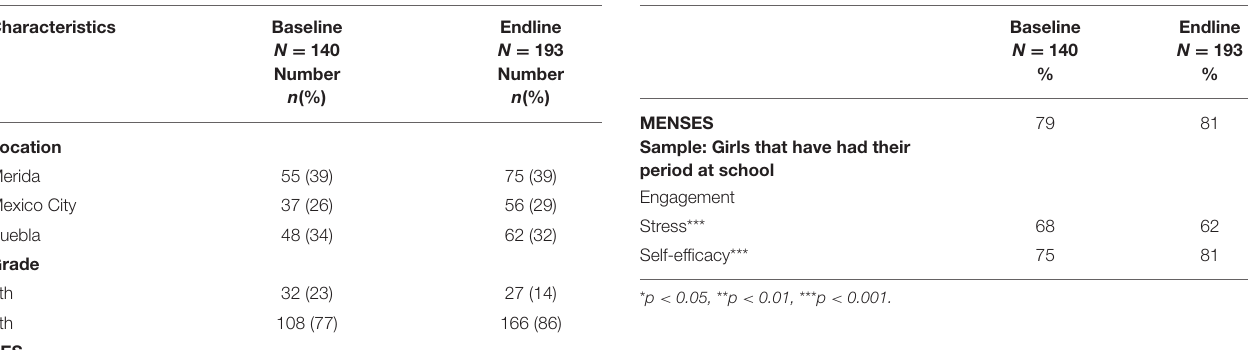
TABLE 3 | Comparison of baseline and endline changes in MENSES